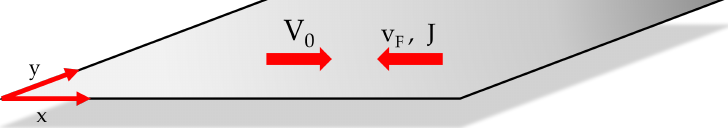
Figure 1. Representation of the domain under study, showing the adopted sign convention. Electric potential and current density present opposite directions, which explains the negative sign in the admittance definition in Equation